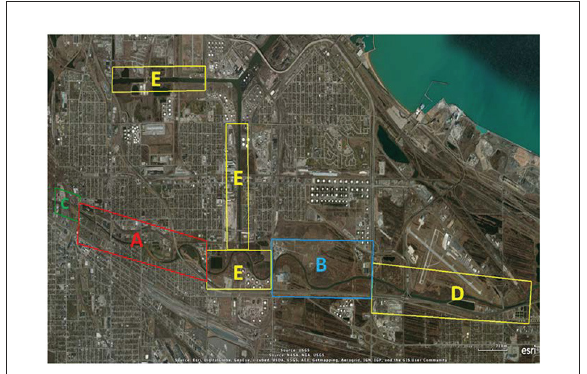
FIGURE2 Grand calumet area of concern remedial action plan map designating zones